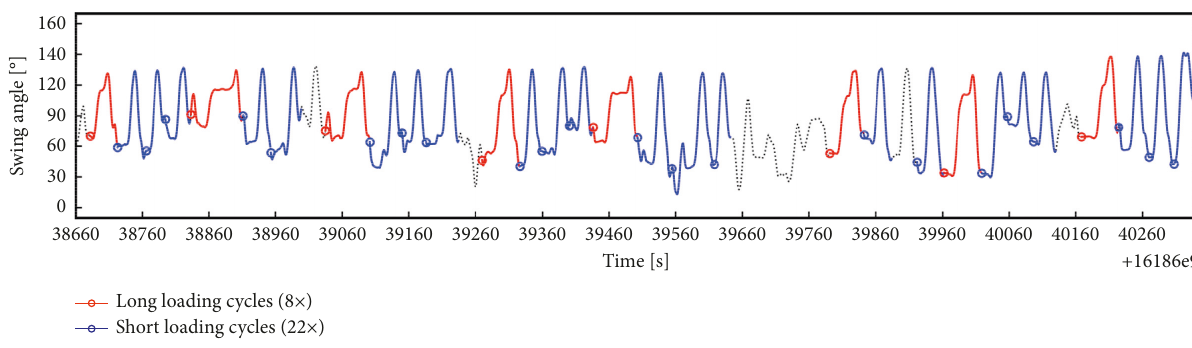
Figure 8: Classifying different loading cycles in a time series. The circle ( ◦ ) denotes the starting point of a found loading cycle. Table 3: Verification of loading cycle recognition algorithm